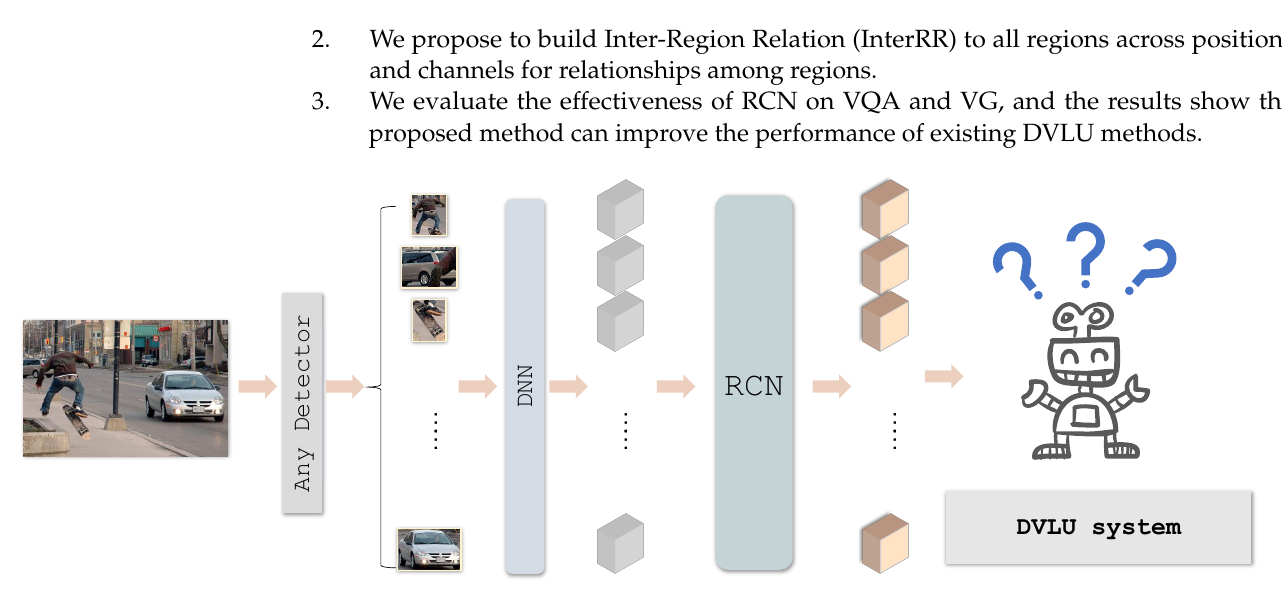
Figure 2. Region Collaborative Network (RCN) can be inserted into a Detection-based Vision- Language Understanding (DVLU) pipeline. Any object detector can be used to generate